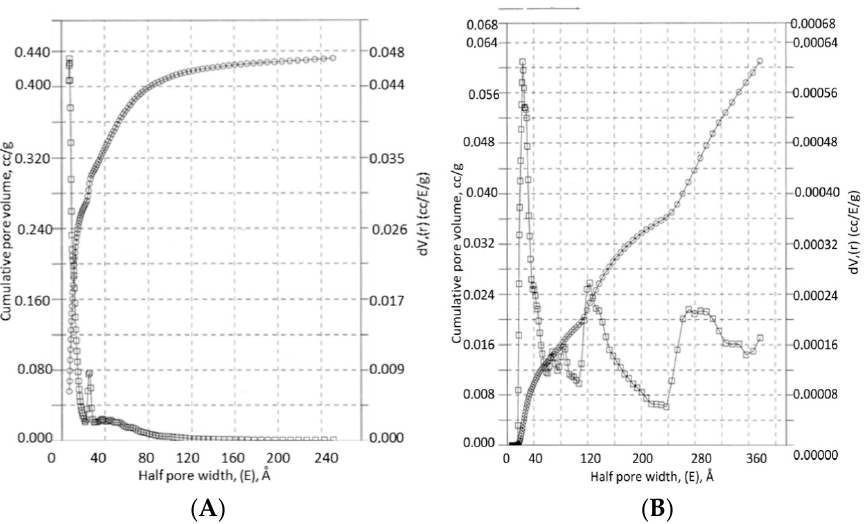
Figure 2. The functions of pore volume distribution on the effective radius for both bactericidal membranes studied. Cu–carboxymethylcellulose grafted on cellulose fibers with activated carbon ZL-302 ( A ), cellulose-chrysotile fibers-Al(OH) 3 (Ssp. = 14 m 2 /g; Vs = 0.12 cm 3 /g) ( B ), ○ —V, □ —dV. 1. Water purification from microorganism using bactericidal membranes: Cu–carboxymethylcellulose grafted on cellulose fibers with activated carbon (Cu–CMC 1–3), and Al(OH) 3 —chrysotile fibers-cellulose (CCHA 1–3); CFU/mL—bacteria concentration in colony forming units in solution.